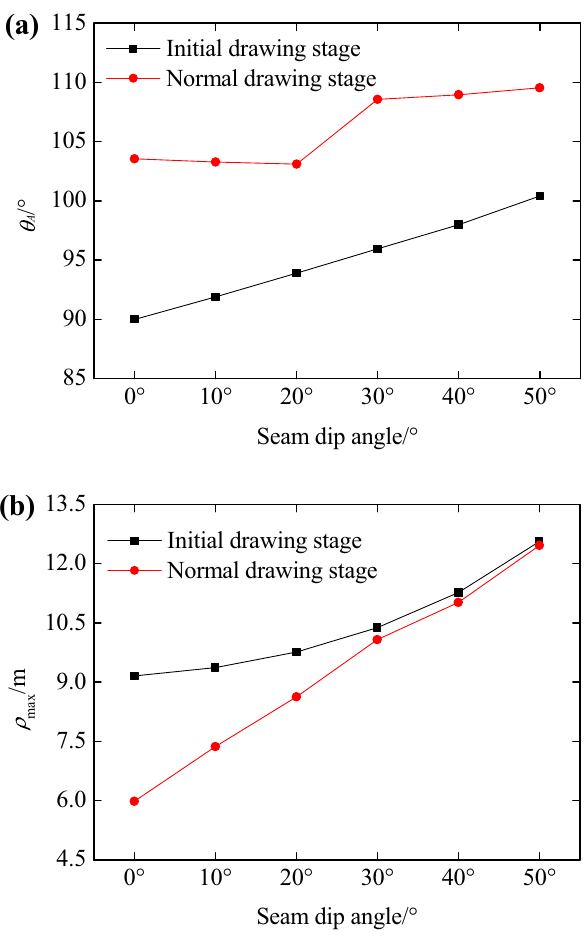
Fig. 15 Variations of a h A and b q max in the initial and normal drawing stages